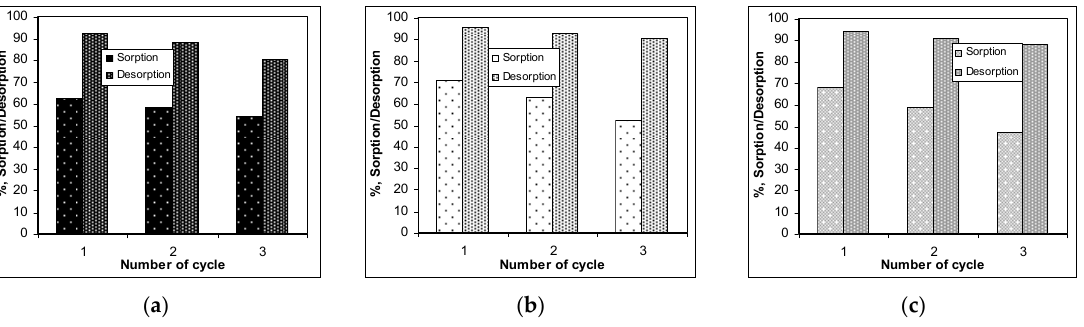
Figure 8. Sorption/desorption percentages obtained at retention of Co(II) ions on ( a ) ABC, ( b ) MBC, and ( c ) SBC.